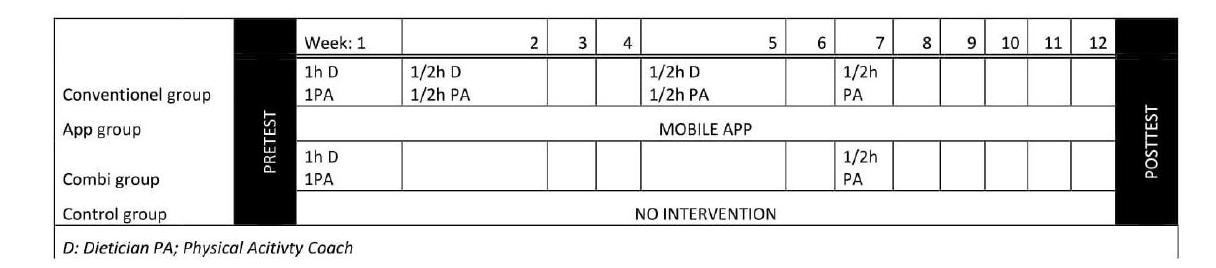
Figure 1. Description of